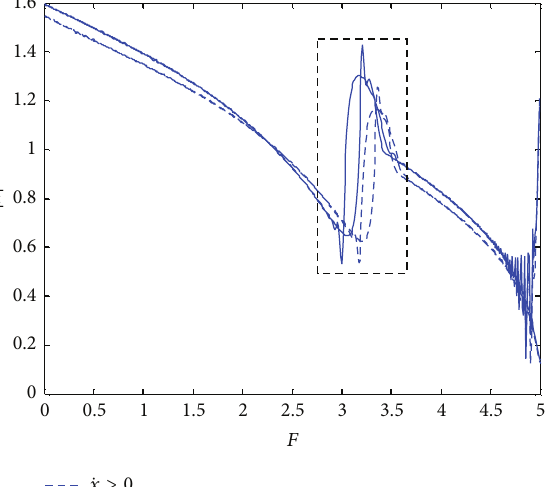
Figure 6: Relationship between 𝑝 3 and 𝜔 .